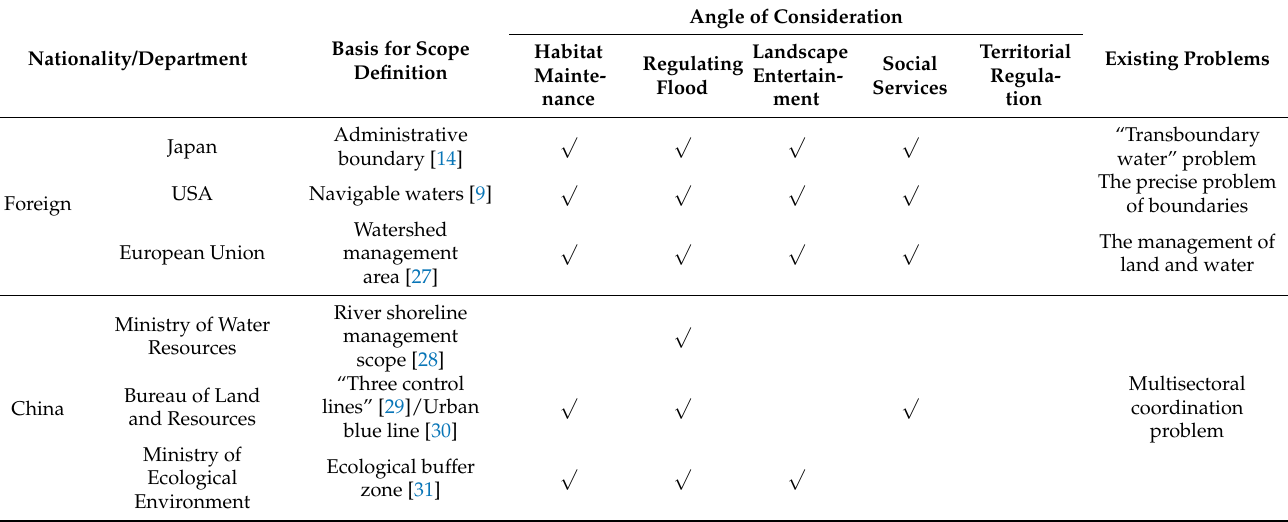
Table 2. Research status and deficiencies of the river ecological corridor management scope in various